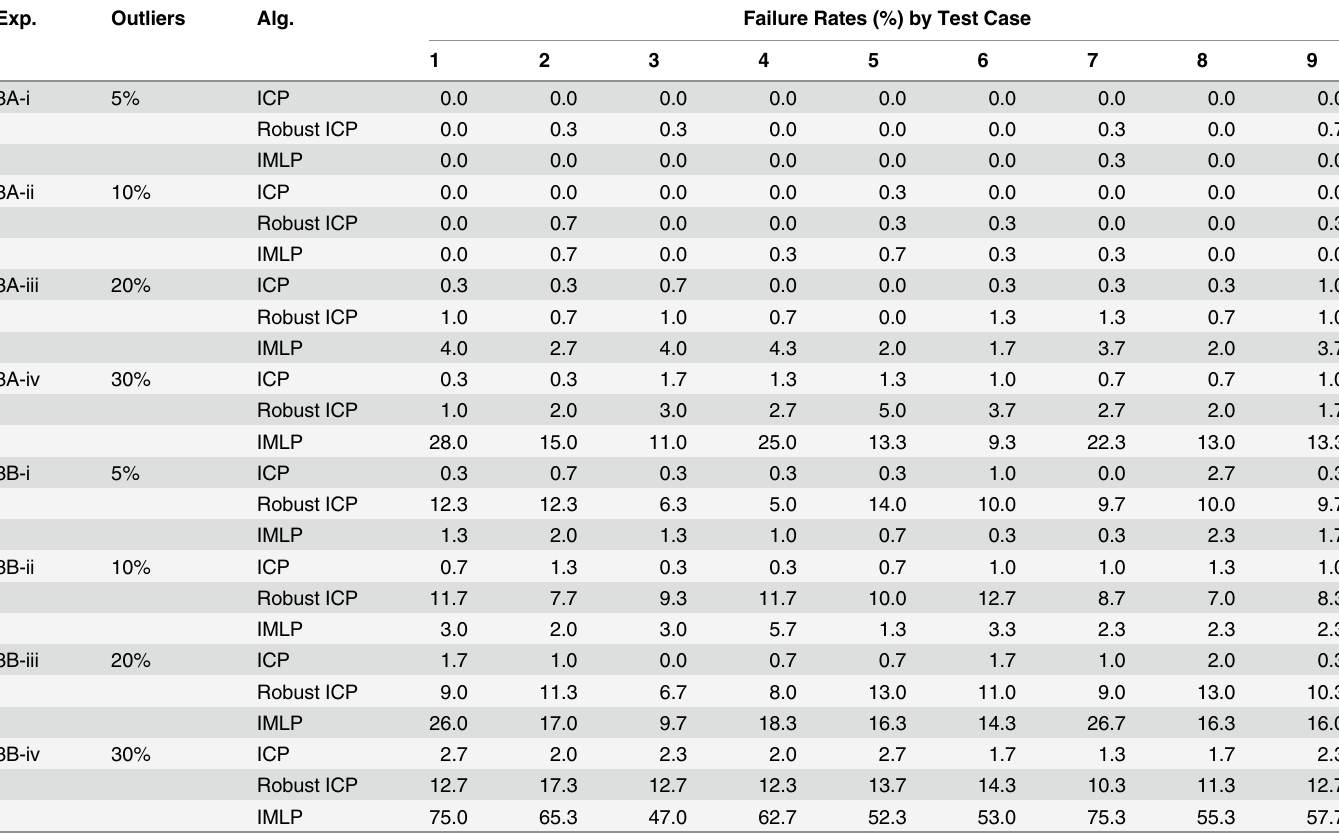
Table 7. Registration failure rates for registering a mesh target shape with outliers. (Experiment 3).